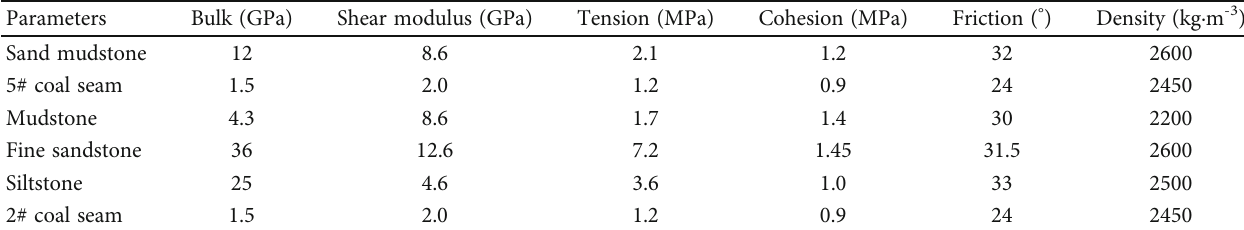
Figure 4: Numerical model of reused Table 1: Physical and mechanical parameters of rock stratum.